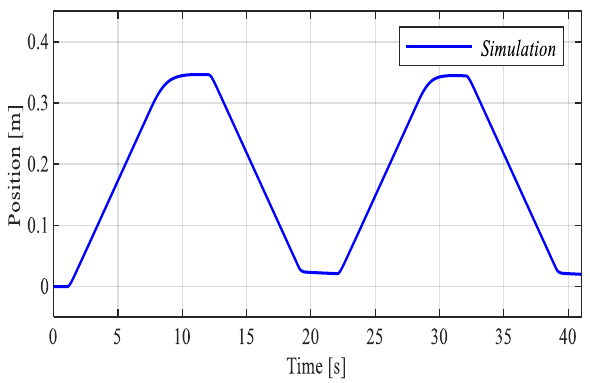
Figure 11. Pump/motor rotational speed.